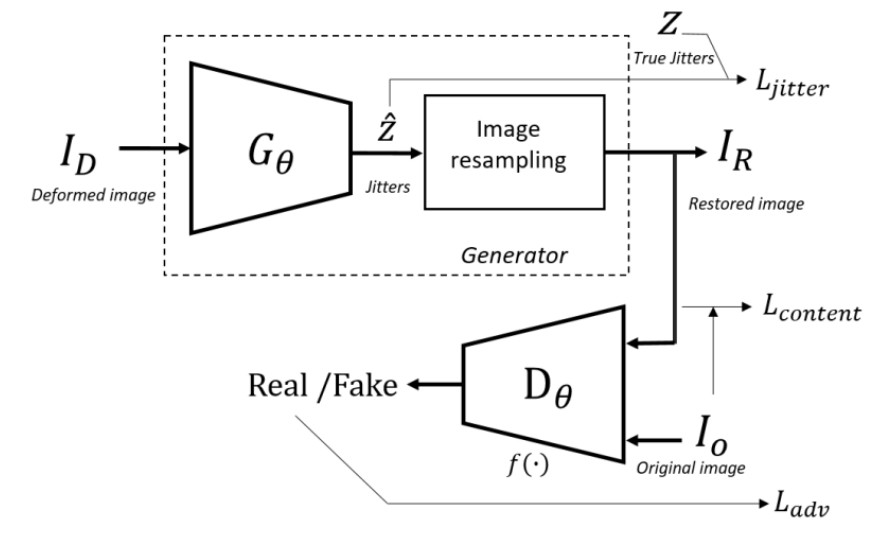
Figure 3. Overview of the proposed